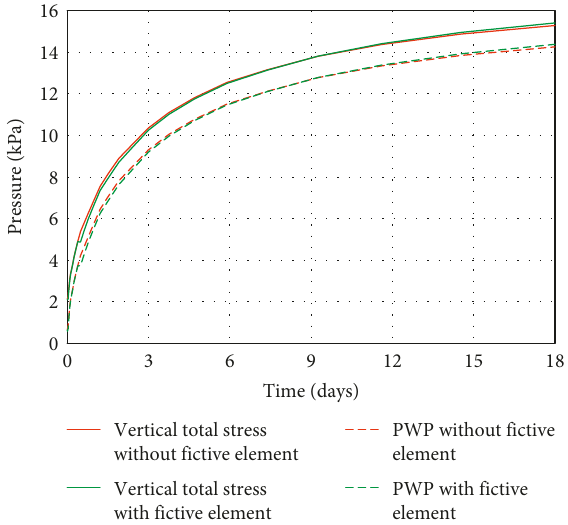
Figure 16: Evolution of the PWP and vertical total stress on top surface of the backfill, obtained by the numerical modeling with and without (this study) fictive elements above the top surface of the